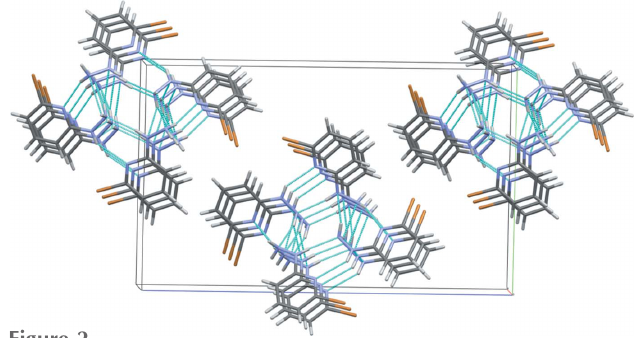
Figure 2 Molecular packing of ( I ). Hydrogen bonds are shown as cyan dotted lines. Crystallographic axes colour codes: a – red; b – green; c –